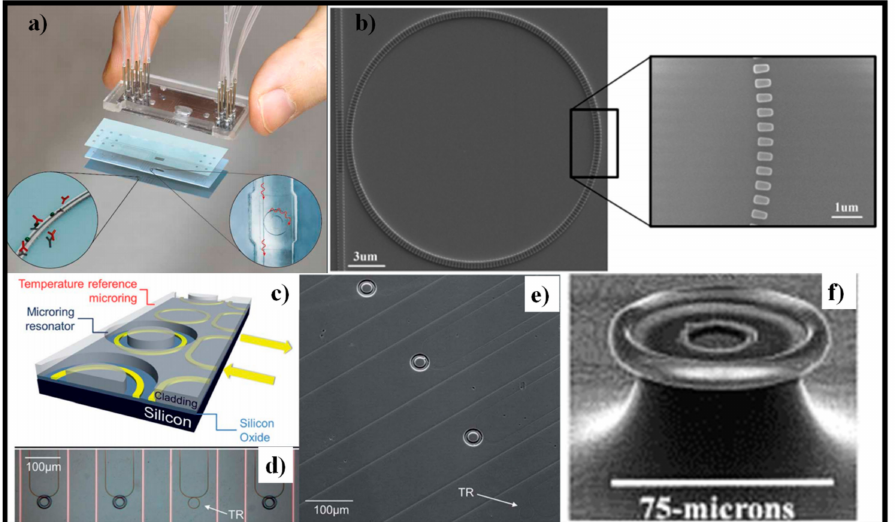
Figure 3. Different micro-ring resonator (RR) designs: ( a ) a packaged optical slot-WG RR sensor array for multiplex label-free assays in labs-on-chips. Reprinted from ref. [42]; ( b ) sub-wavelength grating for enhanced RR biosensor. Reprinted from ref. [46]; ( c ) three-dimensional (3D) graphical illustration of several adjacent devices on a Si photonic µ -RR biosensor array. Reprinted with permission from ref. [47]; ( d ) a brightfield micrograph showing an array of Si photonic µ -RR biosensors. Reprinted with permission from ref. [47]; ( e ) SEM image showing an array of three exposed µ -rings and one temperature reference µ -ring. Reprinted with permission from ref. [47]; ( f ) microtoroid resonator. Reprinted with permission from ref.